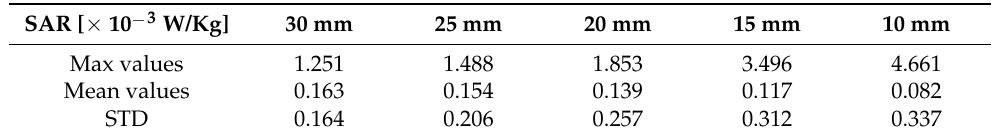
Table 1. SAR values according to the change in size of single-channel surface RF coils using a mouse